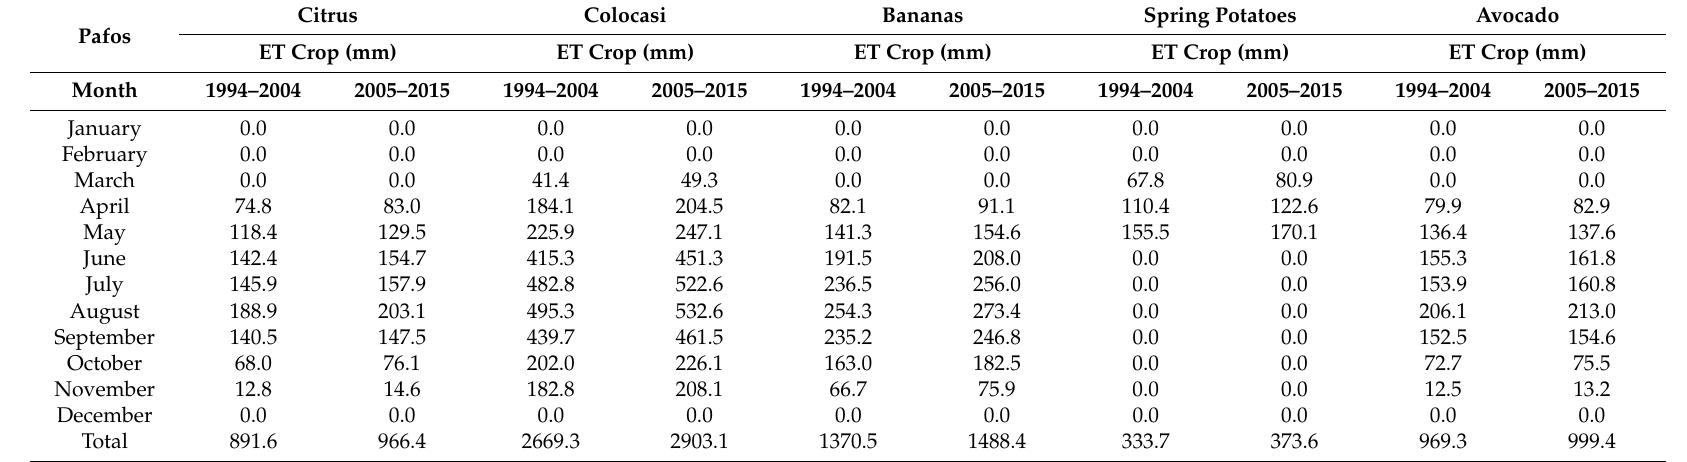
Table 2. Average monthly ETc values for each crop for the Pafos area.